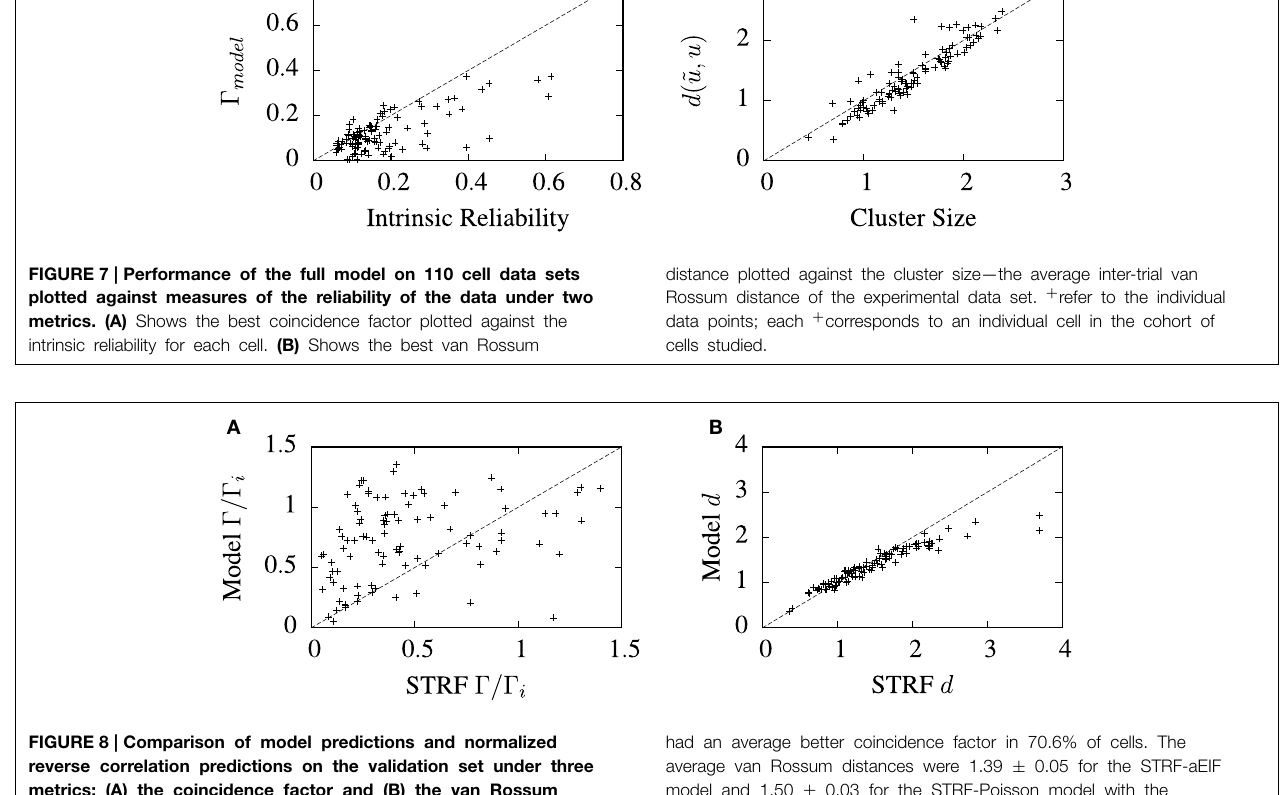
FIGURE 8 | Comparison of model predictions and normalized reverse correlation predictions on the validation set under three metrics; (A) the coincidence factor and (B) the van Rossum distance. The average values of the coincidence factor scaled by the intrinsic reliability were Ŵ = 0 . 76 ± 0 . 08 for the STRF-aEIF models and Ŵ = 0.61 ± 0.05 for the STRF-poisson model. The STRF-aEIF model